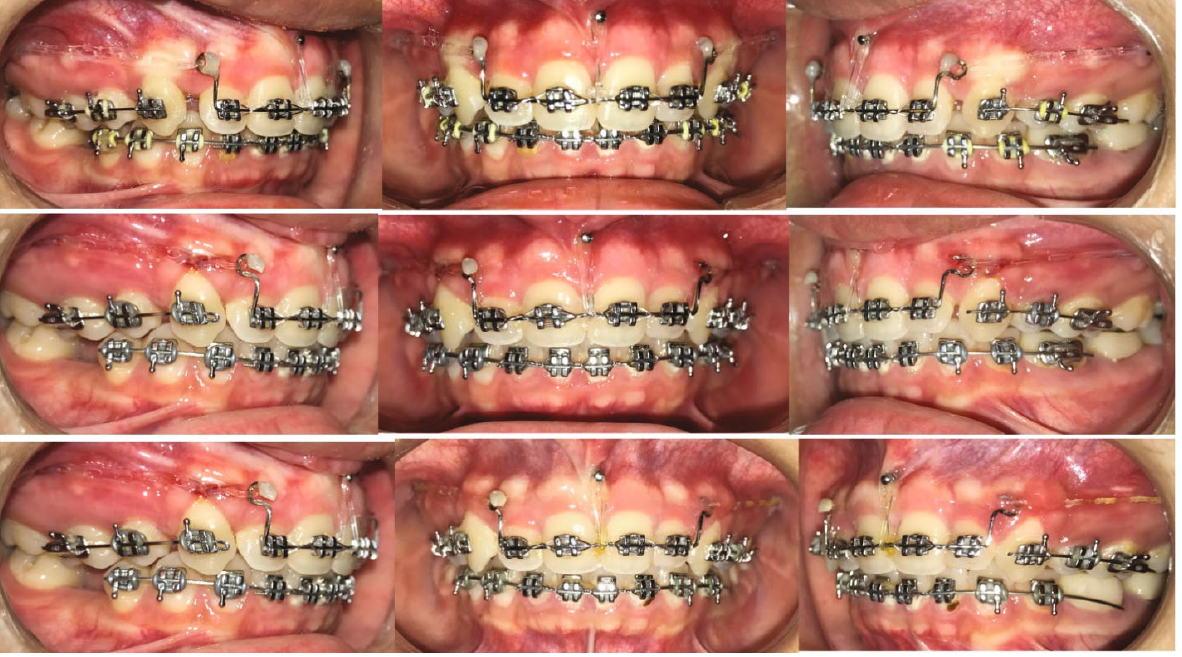
Figure 4: Retraction and simultaneous intrusion of anterior